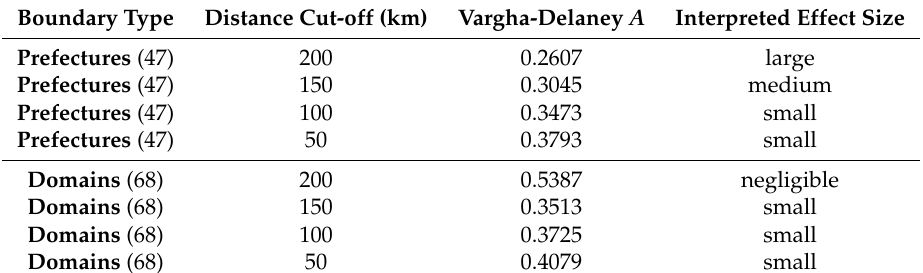
Table 2. Global results of testing the effect of administrative boundaries. The density plots for 150 km distance cut-off cases are presented in Figures 12 and